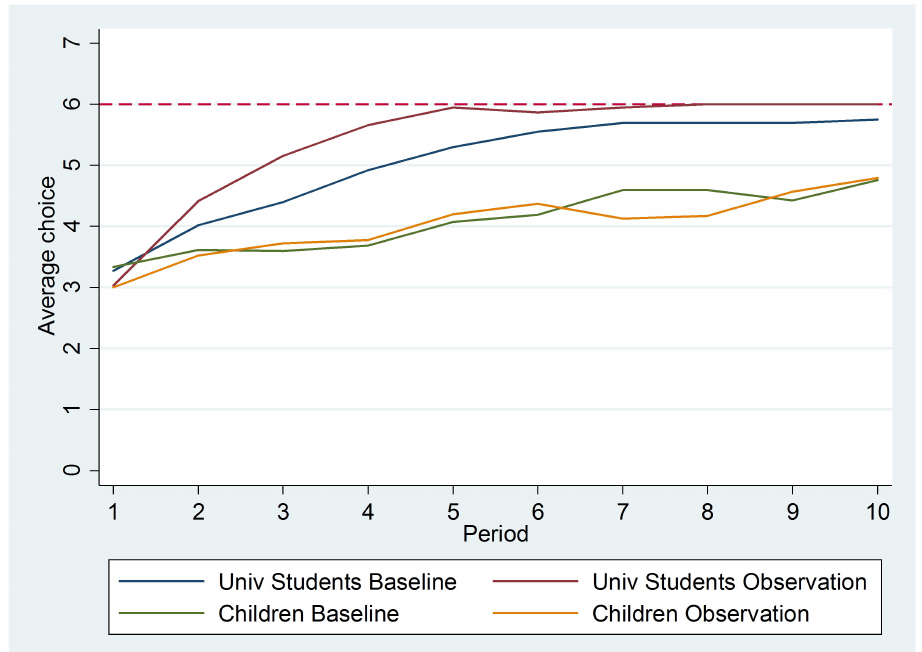
Figure 3. Average choices over